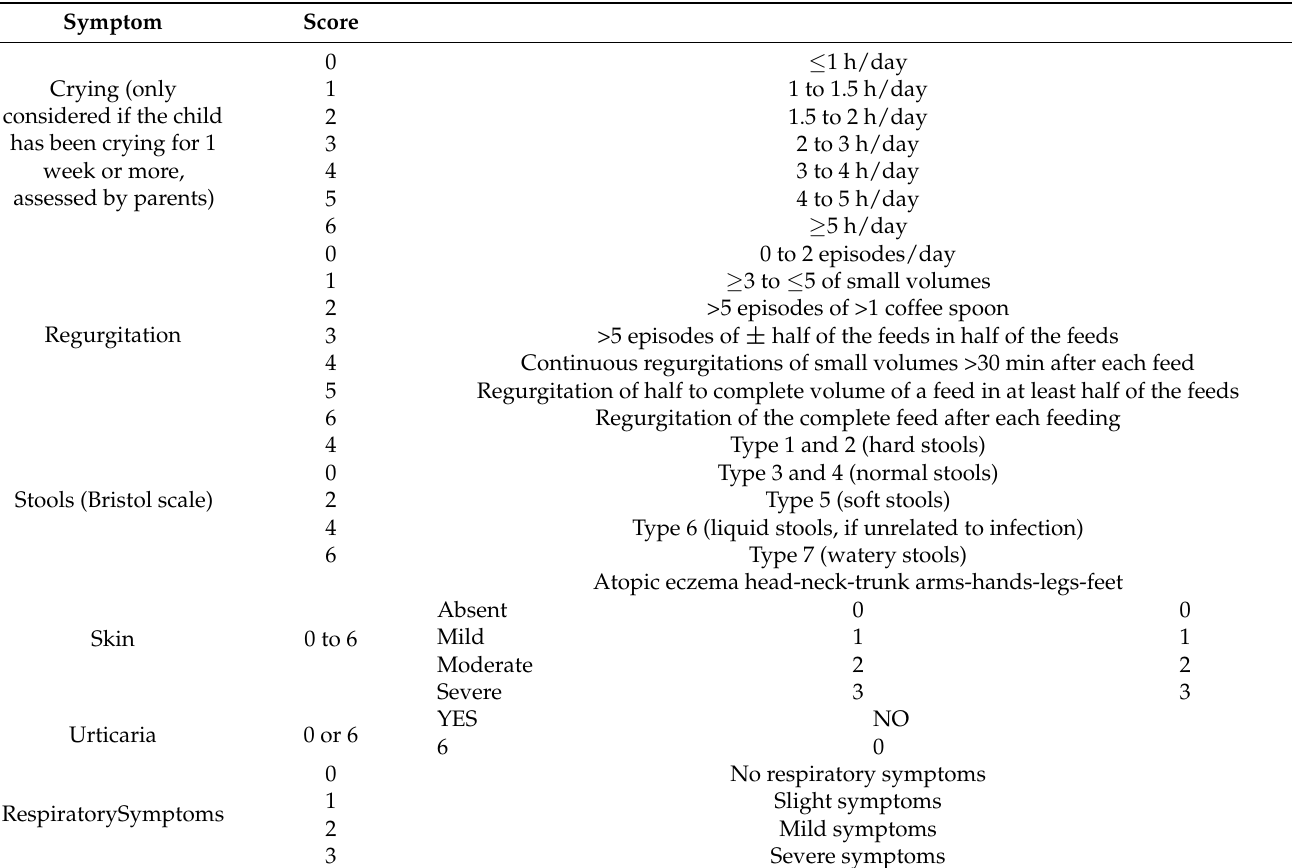
Table 5. CoMiSS ® : Cow’s Milk-related Symptom Score.